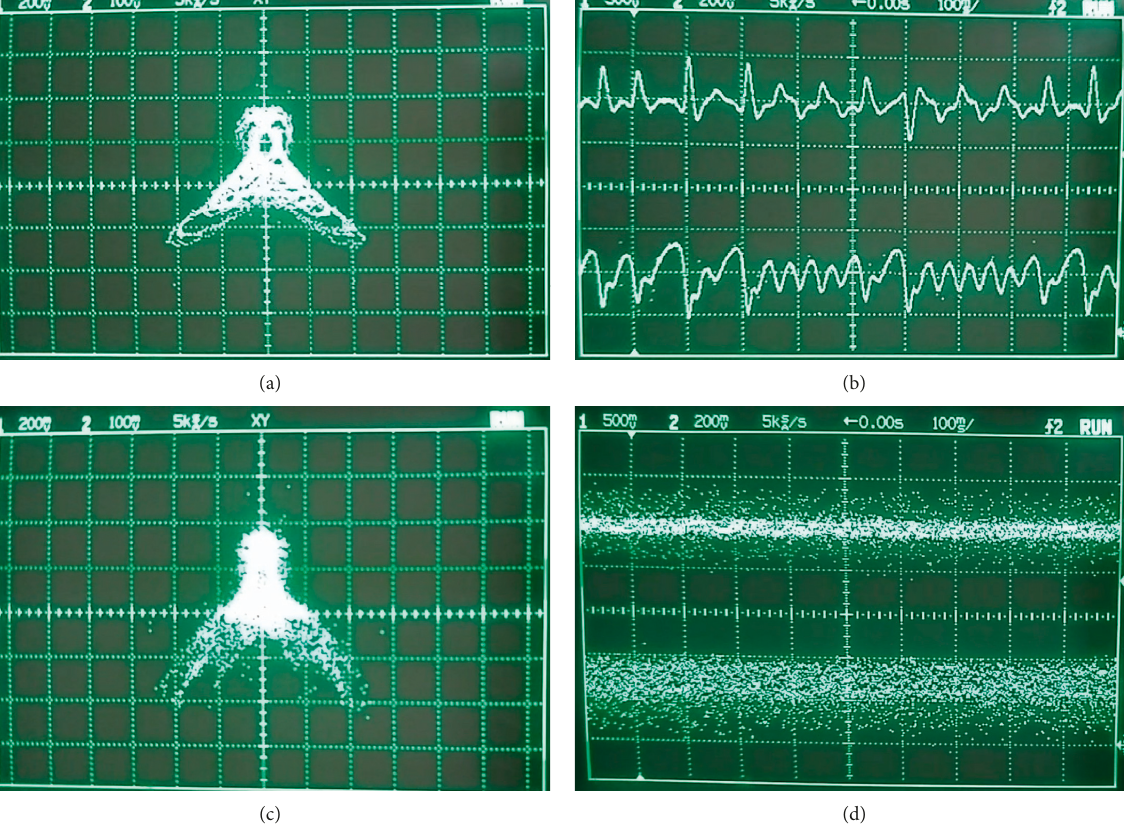
( n ) versus z ( n ) , (b) evolution of state variables